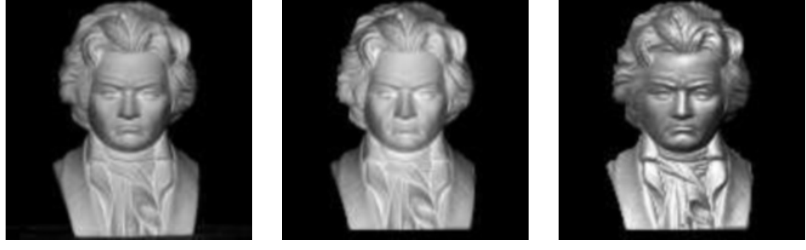
Fig. 6 Reprojected Beethoven images. Left: second input image for PS. Middle: reprojected second image obtained using the PPN method. Right: reprojected second image using the PPS